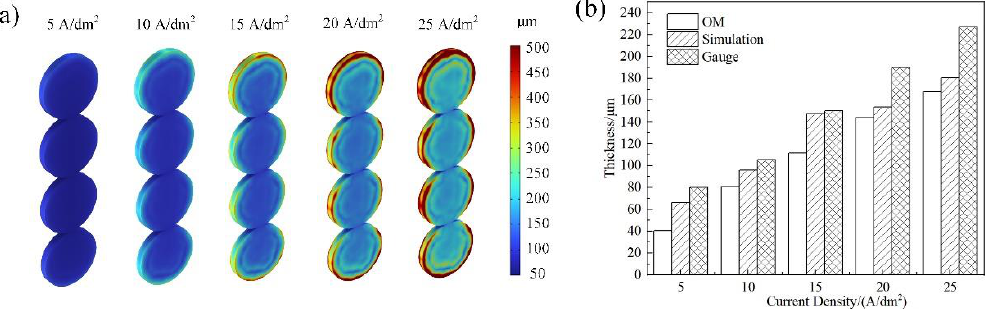
Figure 4. ( a ) Simulated coating thickness at different current densities and ( b ) comparison between simulation and testing results.